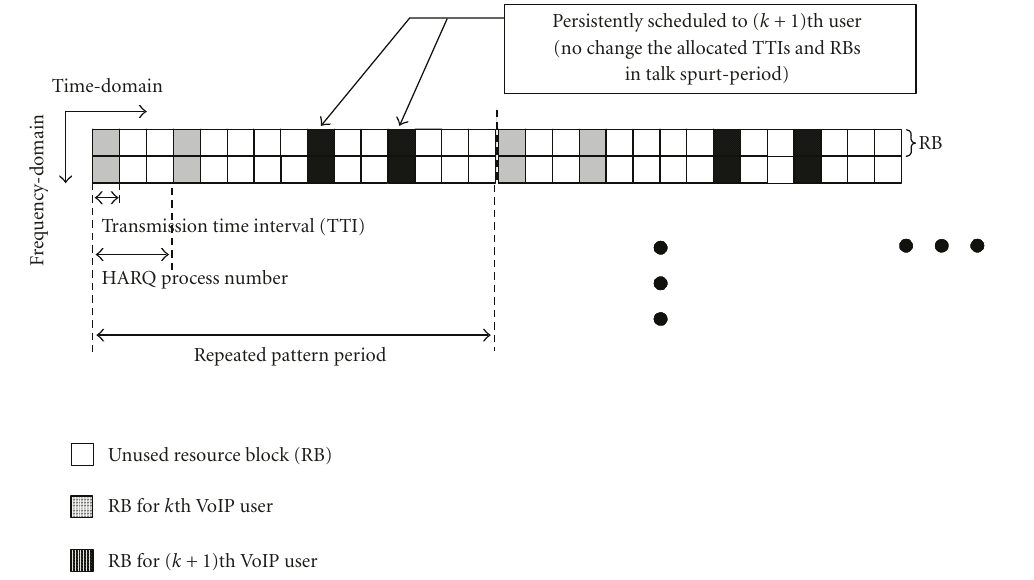
Figure 1: Resource assignment scenario according to the original persistent